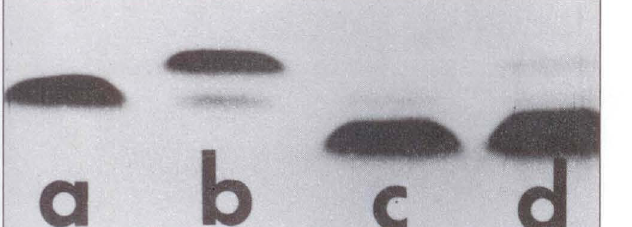
Figure 2) a Silver-stained lipopolysaccharine (LPS) of the parent strain with the tenninal group on it. b Under the influence of cytidine 5' -monophospho-N-acetylneuraminic acid. (CMP-NANA). the molecular weight increases because it is sialylated. A smaller second component in the gel underlying the first is not affected: c The LPS of the pyocin-selected mutant does not have that tenninal group on it: d The molecular weight of the mutant LPS does not increase under CMP-NANA treatment